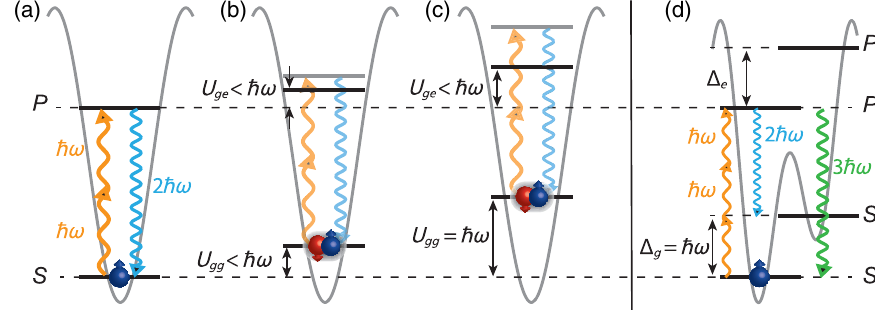
FIG. 5. Dissipation control scheme in the atomic limit for off-resonant and near-resonant driving. This simplified schematic applies to the strongly localized case, the atomic limit, in which the Hubbard U (a) – (c) or, equivalently, a strong site offset Δ (d), prohibits g tunneling. For strong interactions, two types of states have to be considered: the single occupancy (a) and the double occupancy (b). In the singly occupied case (a), the two-frequency control scheme applies as in the noninteracting regime (as explained in the main text). In the doubly occupied case (b), the distinction between the lower-band U and the upper-band U interaction leads to a shift in the gg ge higher-band resonance [19], reducing the excitation rate to the higher band. The same logic as in (b) applies to near-resonant driving (c) in which ℏ ω ¼ U , showing no additional loss features. Near-resonant driving with a static tilt Δ in the noninteracting regime gg g (d) can lead to additional resonances, depending on the overlap of the S 2 and the P 1 orbitals. If the overlap is small, the control scheme can be used as in (a). If the overlap is large, additional frequencies can be employed to cancel this type of resonance, as shown in (d) for the case of a three-photon resonance from S 1 to P 1 and a two-photon resonance from S 2 to P 1